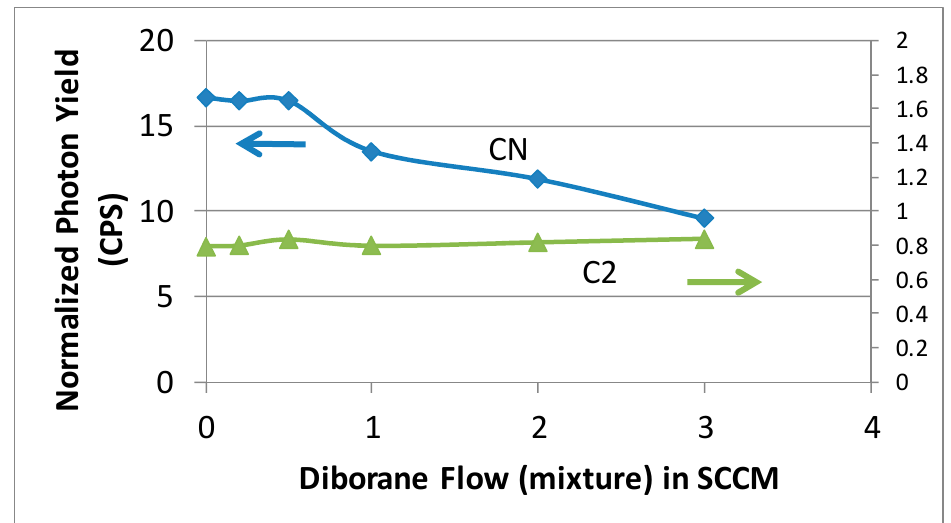
Figure 5. The emission intensity for CN (carbon–nitrogen) and C 2 radical as a function of diluted diborane mixture (10% B 2 H 6 in H 2 ) flow rate in a H 2 /CH 4 /N 2 plasma. The emission intensity has been normalized to the hydrogen H β intensity to account for any changes in optical transmission during the course of measurements.